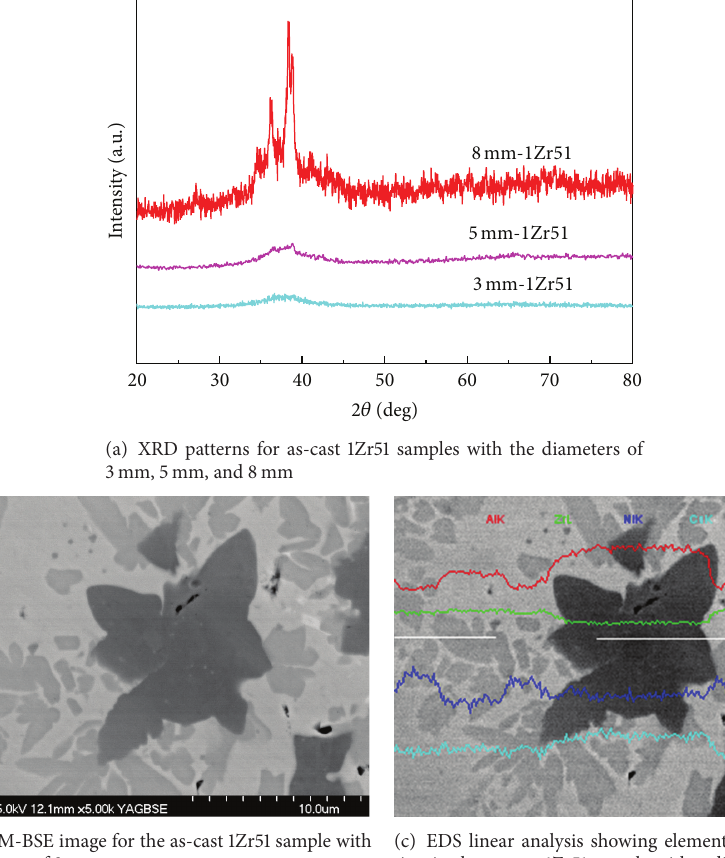
Figure 1: The XRD and SEM patterns for as-cast 1Zr51 samples in different